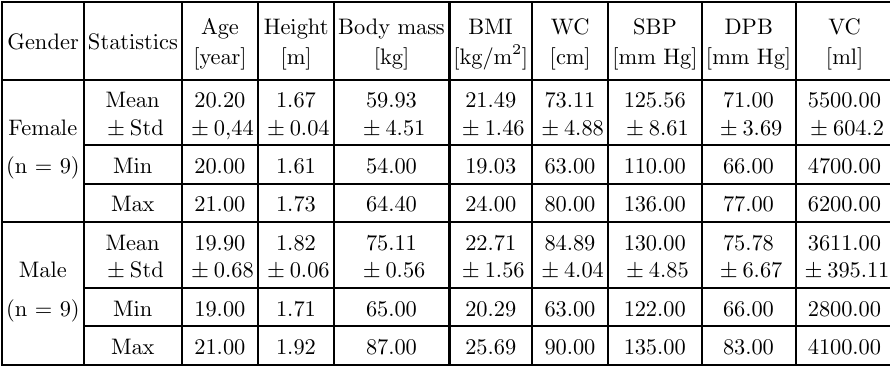
Table 3. Morphological and physiological characteristics of participants at the beginning of the